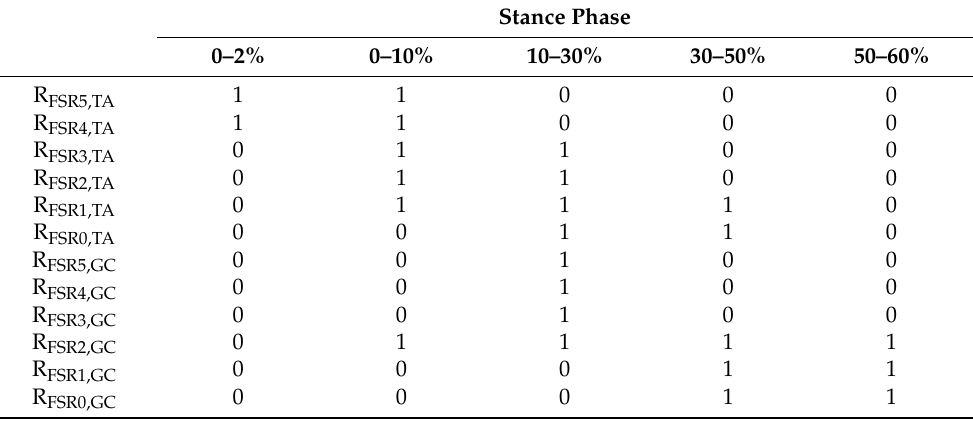
Table 6. The gait map for the stance phase plotted in Figure 19, generated from the cross-correlation functions from Figure 21.